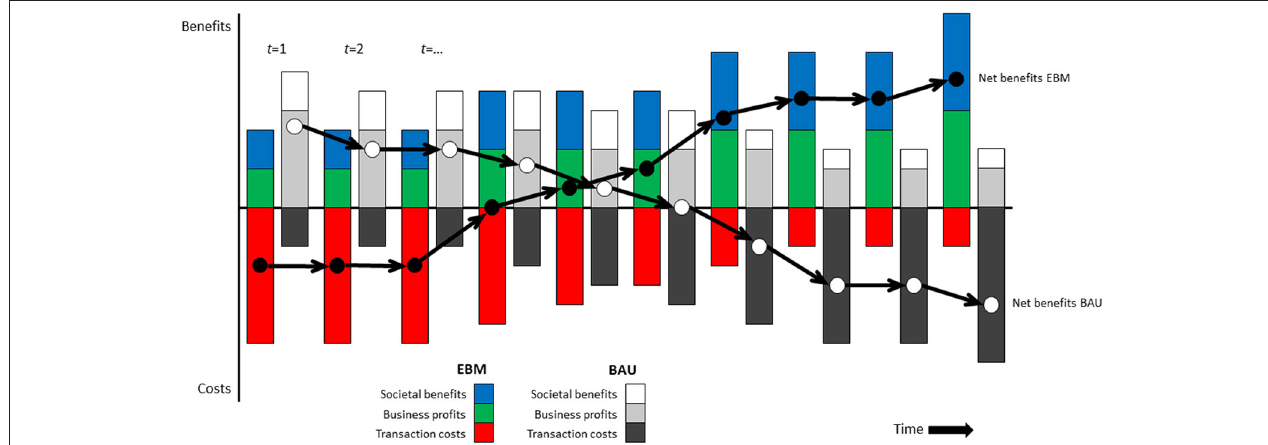
FIGURE 2 | Comparing the projected trajectory of hypothetical net benefits from BAU and EBM